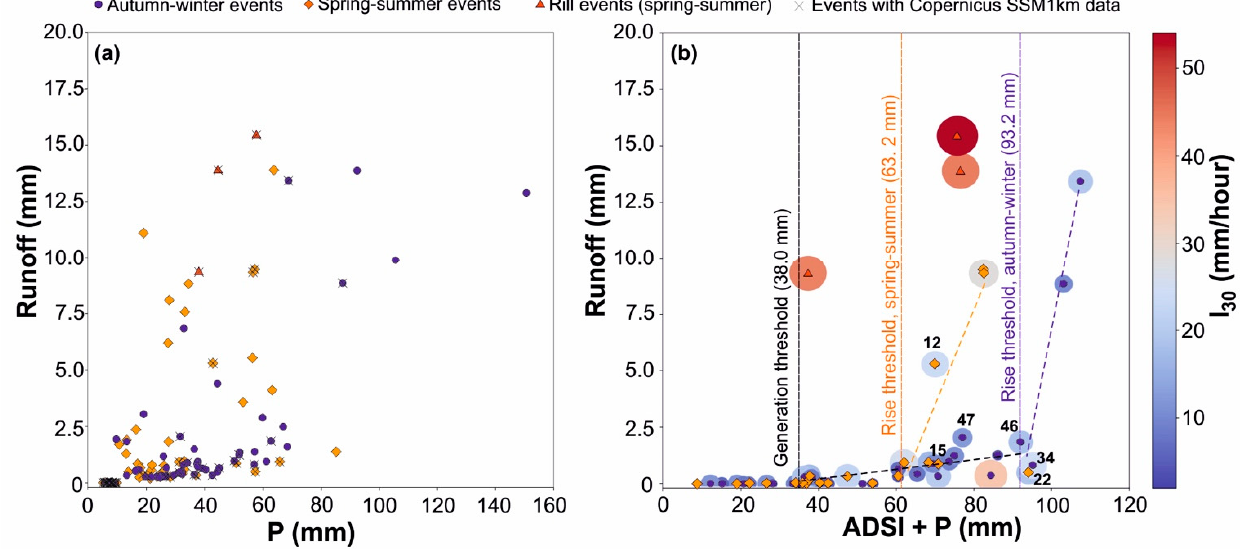
Figure 2. Runoff events separated into spring–summer and autumn–winter periods. ( a ) Runoff vs. event rainfall depth (P) for the 2008–2020 period; ( b ) Runoff vs. the sum of Antecedent Degree of Saturation Index and P (ADSI + P), with generation threshold and rise thresholds for the two periods (only events with Copernicus SSM1km data available are considered, Table S1). The numbers associated with some selected events in Figure 2b refer to Table S1.